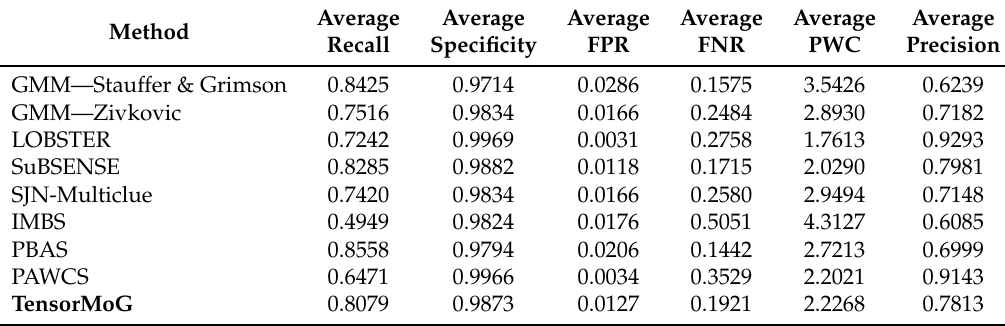
Table 5. Result of quantitative evaluation on CAMO-UOW